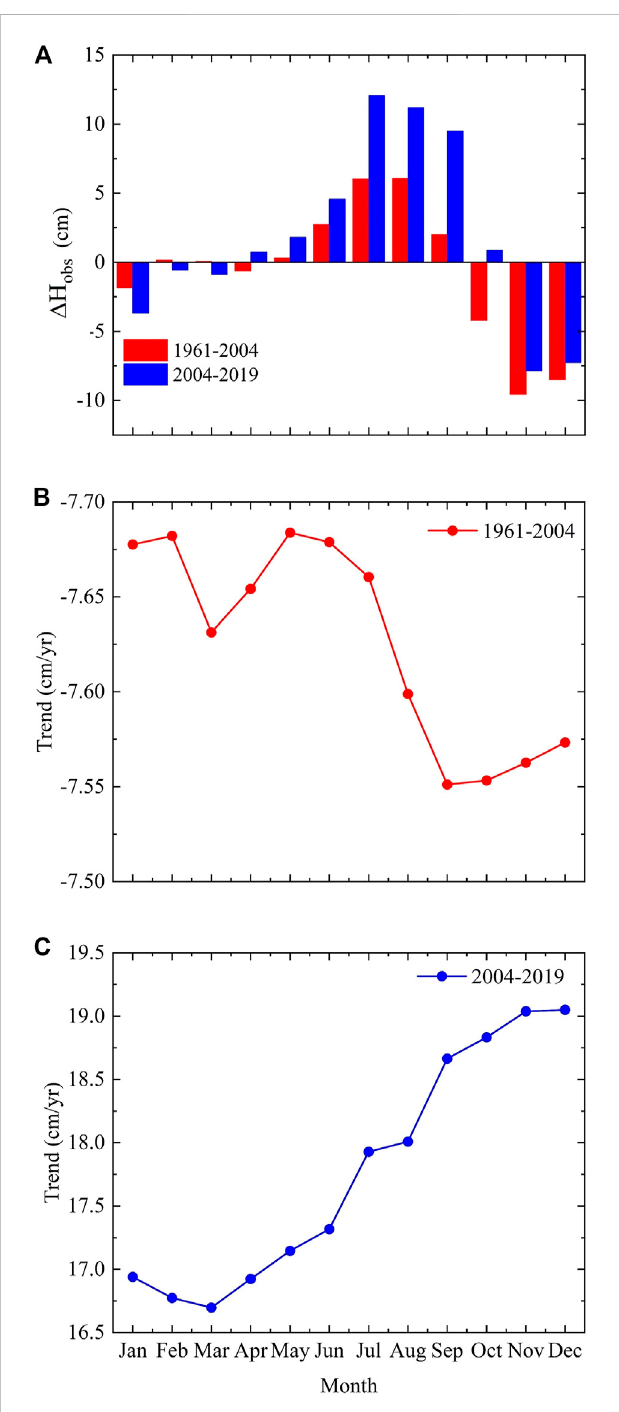
FIGURE 3 Variation of Δ H (A) , and trends of monthly lake water level during 1961 – 2004 (B) and 2004-2019 (C)